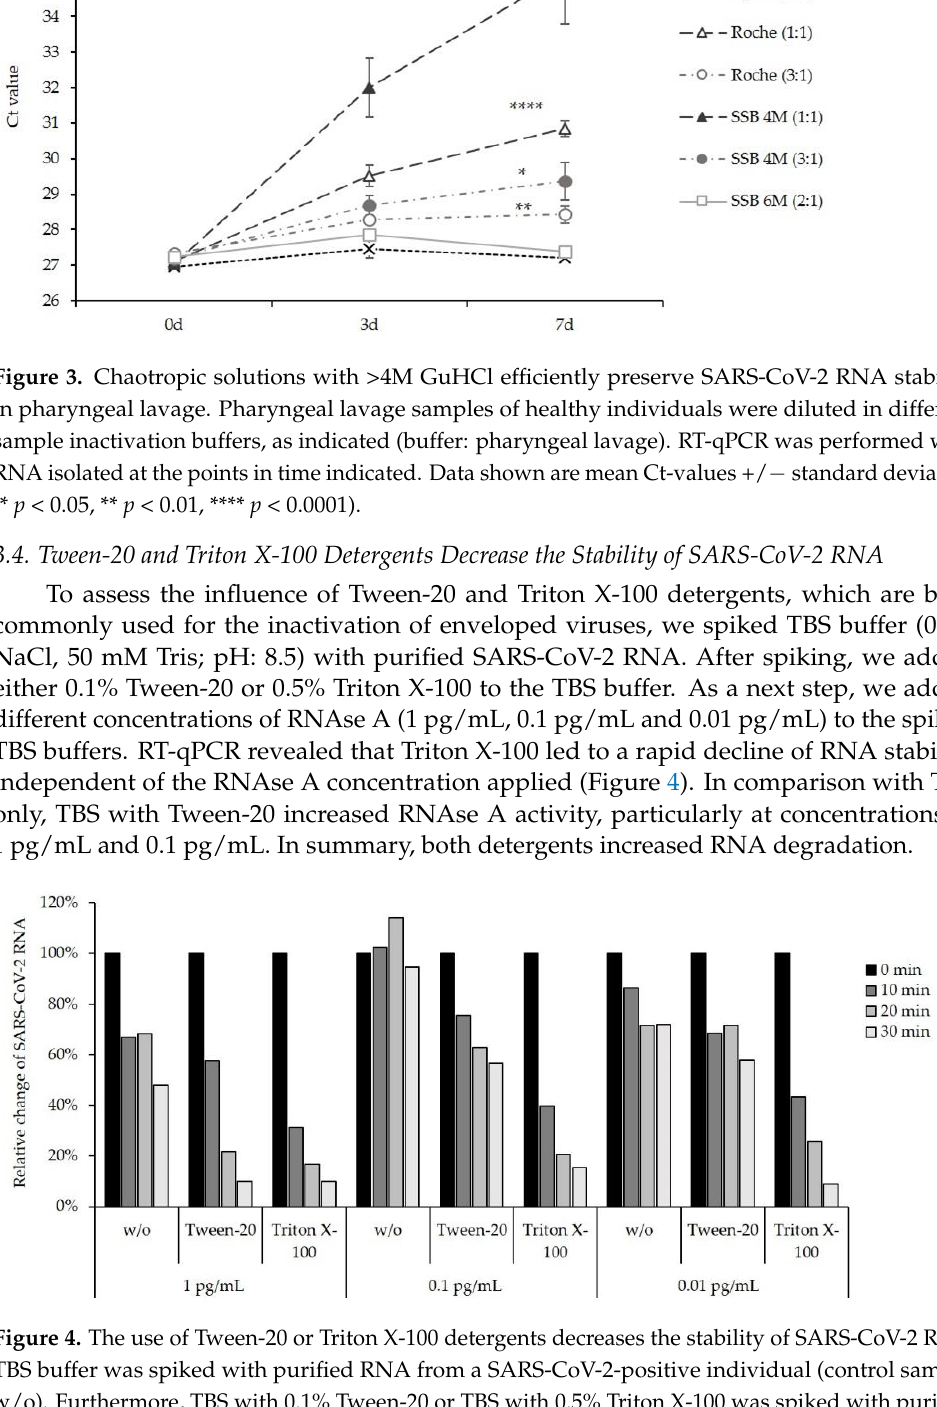
indicated. RNase A activity was measured by RT-qPCR targeting SARS-CoV-2 at different points in time as indicated (0–30 min post-spiking). Data are shown as a relative decrease in SARS-CoV-2